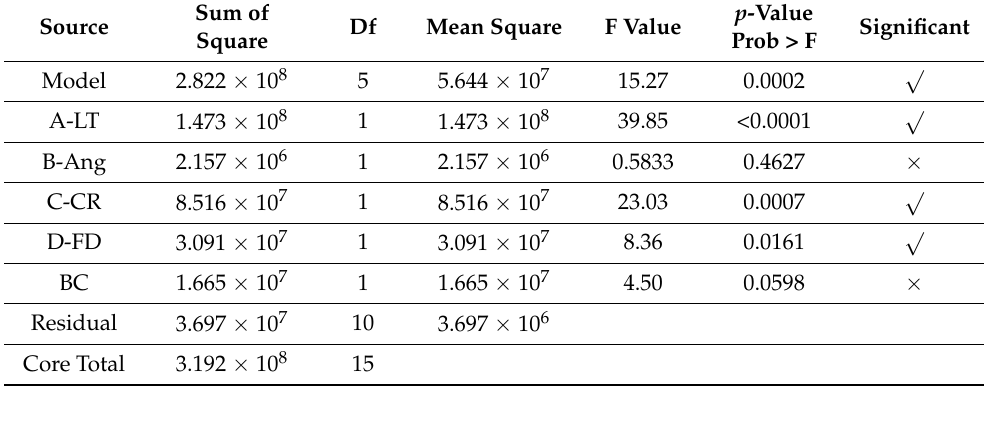
Table 5. ANOVA for reduced 2FI model of Impact Toughness.